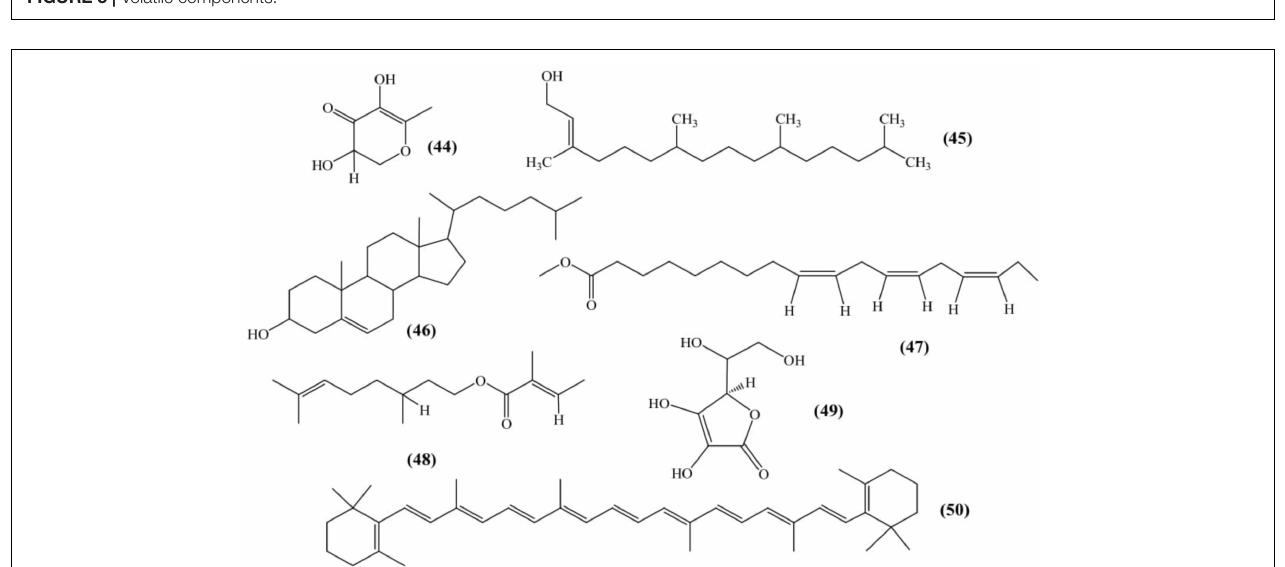
FIGURE 5 | Volatile components.